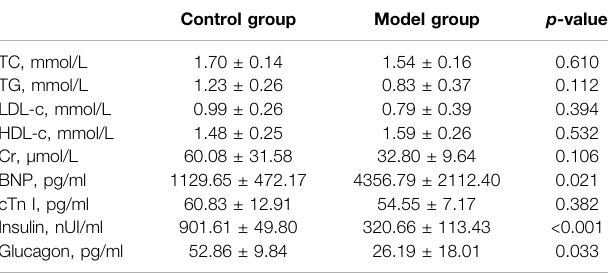
TC, totalcholesterol;TG, triglyceride;LDL-c, low-densitylipoprotein cholesterol;HDL-c, high-density lipoprotein cholesterol; Cr, creatinine; BNP, brain natriuretic peptide; cTn I, cardiac troponin I, data are represented as mean ±